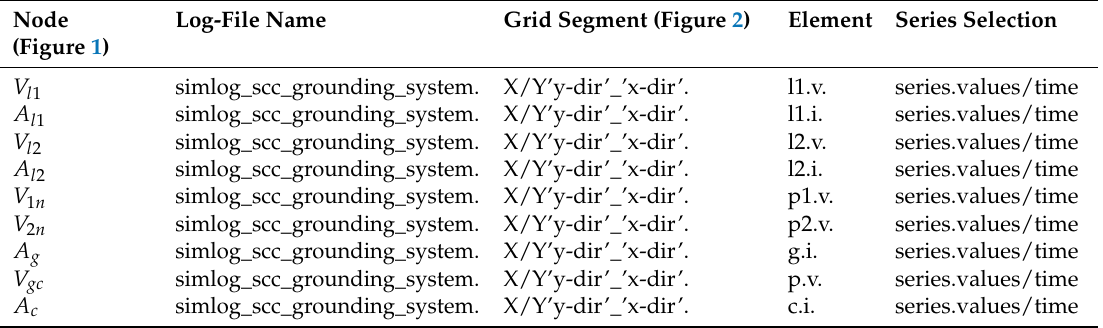
Table A1. Simulation-log nodal measurement overview and grounding system variable